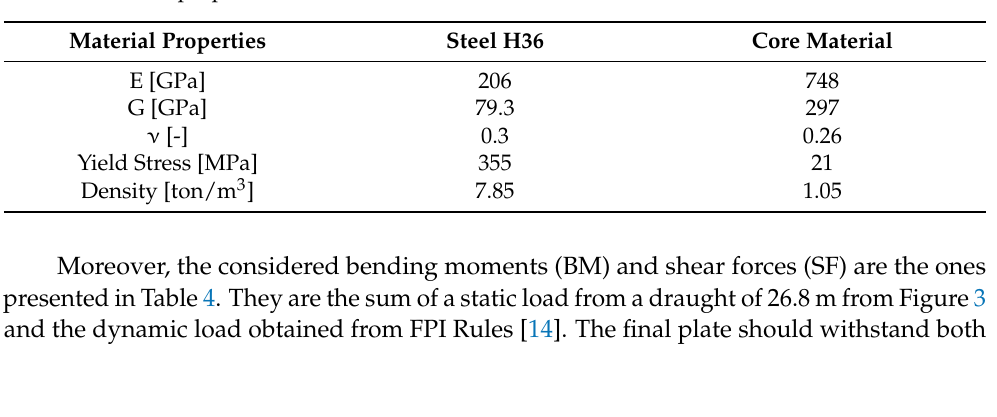
Table 3. Material properties of steel H36 and the core.